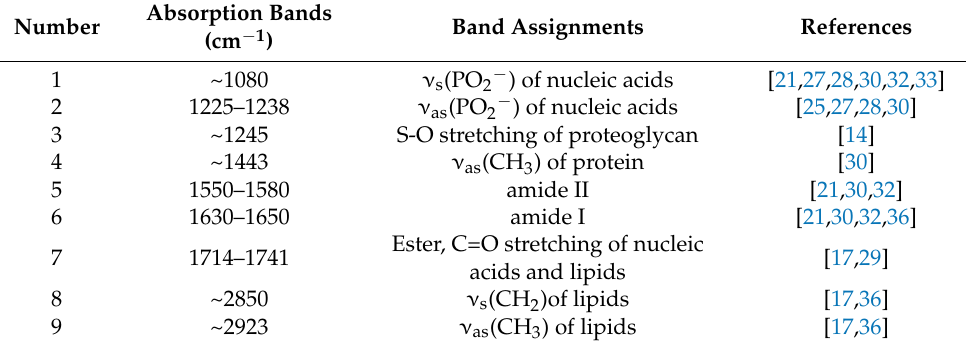
Figure 2. Synchrotron-based FTIR microspectroscopy setup scheme. The collected and collimated synchrotron radiation was transported to an FTIR interferometer bench. Then the modulated infrared beam was focused onto samples. The reflected light from samples was collected and recorded using an IR detector. All infrared spectra data and information were processed by computers [41]. Table 1. Band assignment of major absorptions in SR-FTIR data of stem